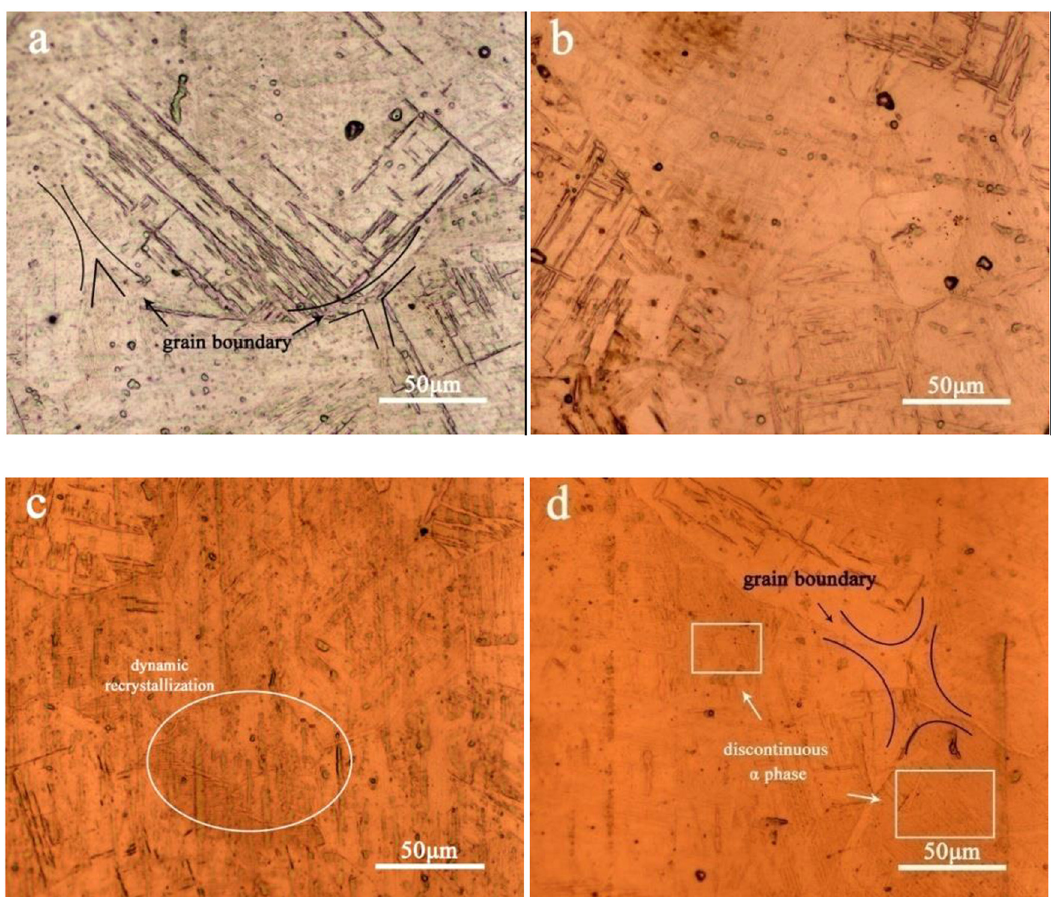
Figure 6: OM images of the samples at the deformation of one - pass: ( a ) 0.01 s − 1 , ( b ) 0.1 s − 1 , ( c ) 1 s − 1 and ( d ) 5 s − 1